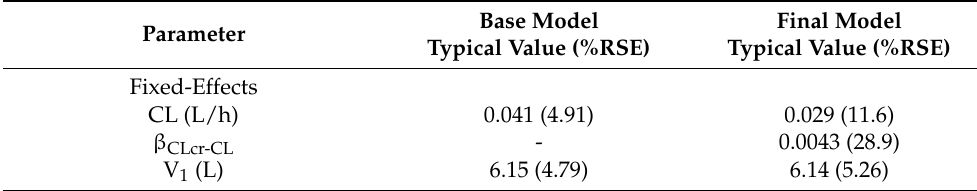
Table 2. Parameter estimates of the base and final dalbavancin population pharmacokinetic